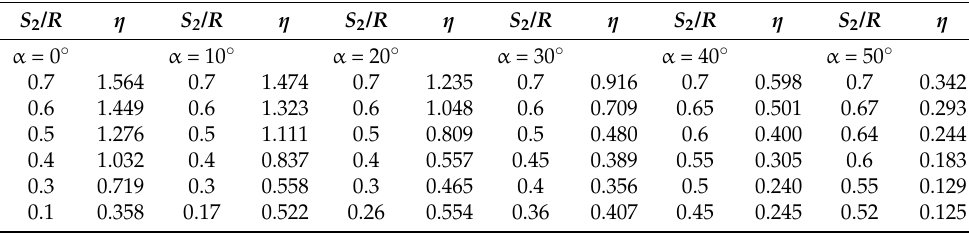
Table 3. Geometry factor η for different values of S 2 /R and crack angle α obtained with values of a/R and S 1 /R fixed, respectively, to 0.4 and